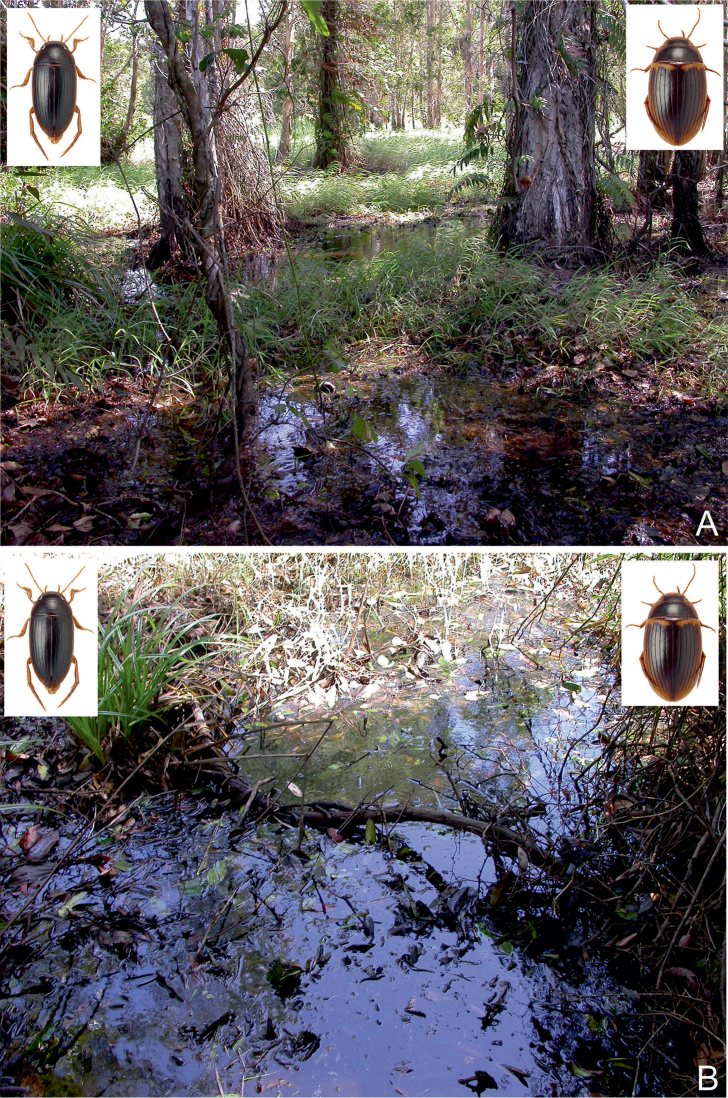
Habitat of Copelatus
tenebrosus and C.
portiorA Queensland, swamp forest at Cape Tribulation Road B shallow and ephemeral swampy puddles with rotten leaves, roots and twigs, Queensland, Cape Tribulation Road. Photographs by L. Hendrich.